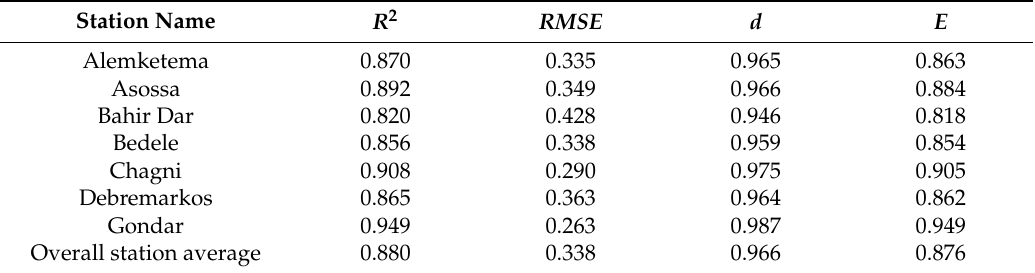
Table 4. A measure of ANN model performance based on all statistical measures of the observed SPEI and predicted